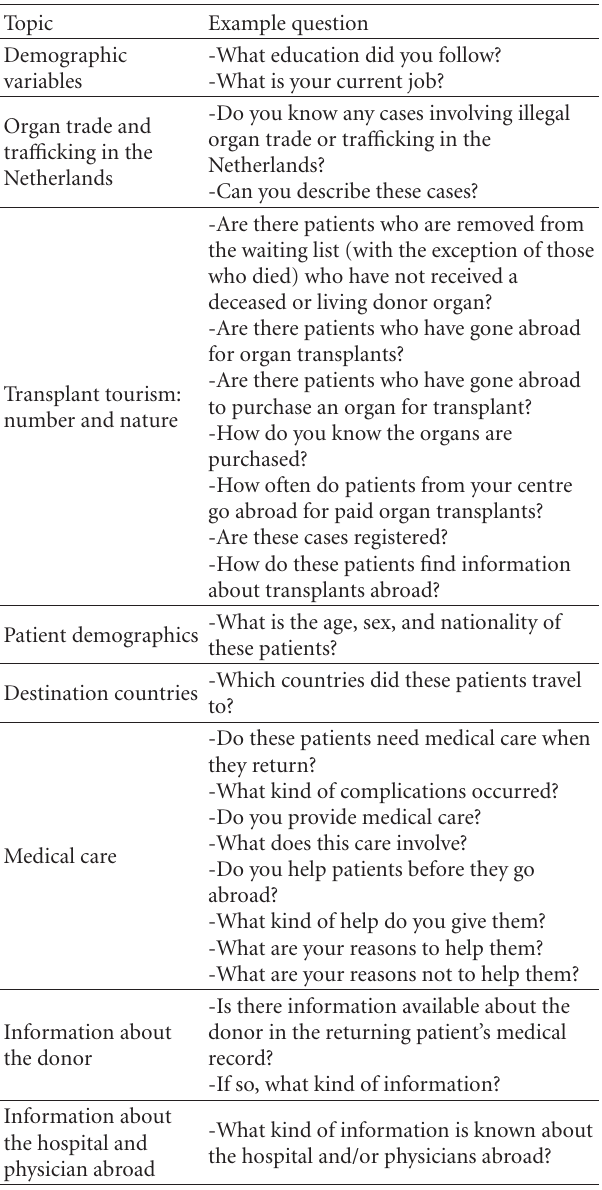
Table 1: Interview topics and example